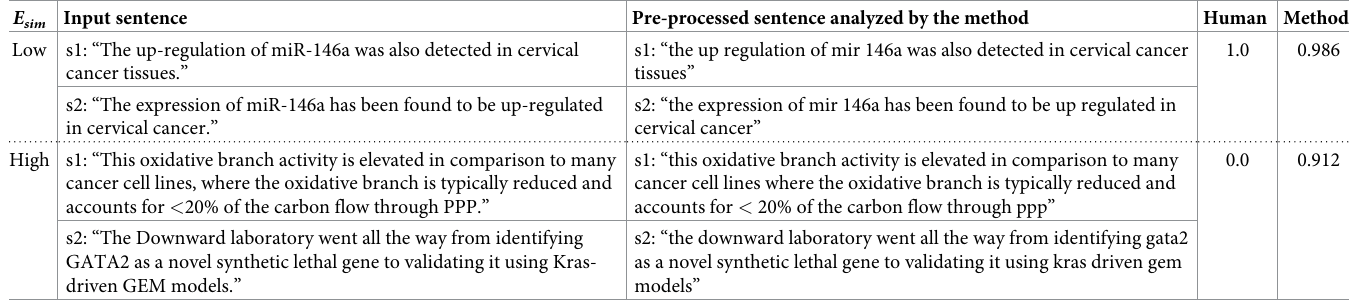
Table 15. Raw and pre-processed sentence pairs obtaining the lowest and highest similarity error E together with their corresponding Normalized human similar- sim ity score (Human) and normalized similarity value (Method) estimated by the BioWordVec int (M26) method for the raw and pre-processed sentence pairs with the lowest (L) and highest (H) similarity error E sim